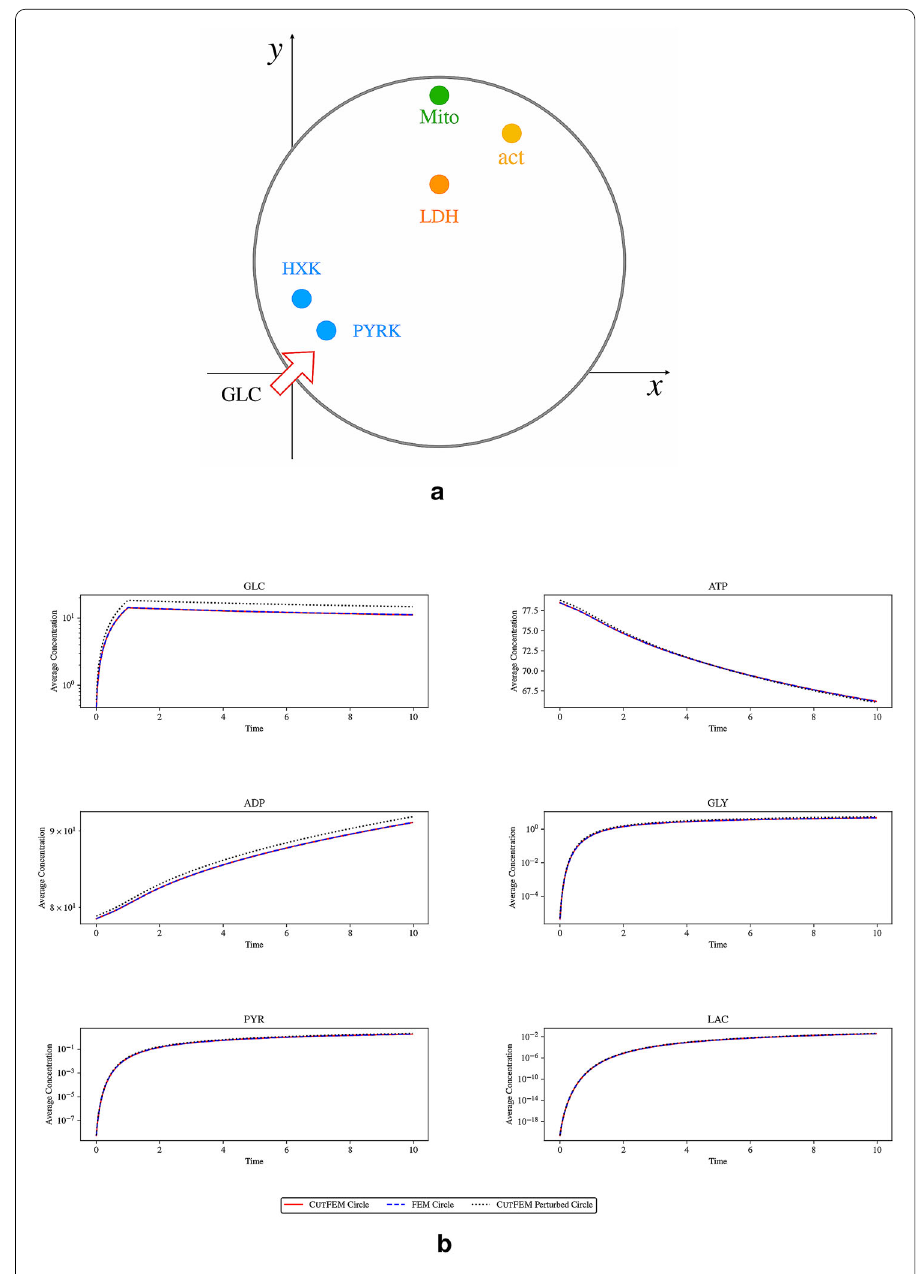
Fig. 6 a The chosen location of the chemical reactions Eqs. (1)–(5) and of the influx of GLC are shown to compare FEM and CutFEM results in a circular domain. b In the y-axis is plot the integral over the domain at each time step using Eq. (23), giving us the average concentration, of CutFEM and FEM in a circular domain and CutFEM solved in a circular domain with perturbed boundary. The average concentration of each species of FEM (blue line) and CutFEM (red line) are equivalent while the CutFEM solutions of the perturbed domain (black line) share the same results for concentrations ATP, GLY, PYR, LAC and differs but show the same trend for GLC and